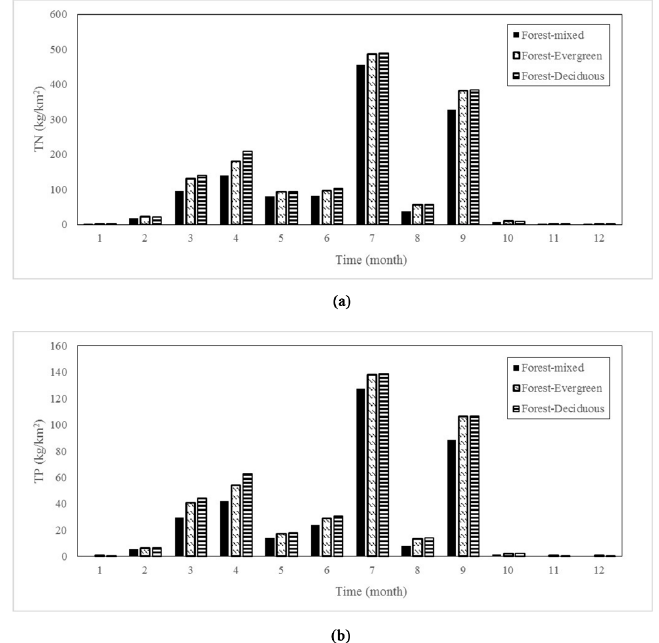
Figure 5. Monthly distribution characteristics of nutrients outputs with different FLTs: (a) was the distribution of TN; (B) was the distribution of TP.